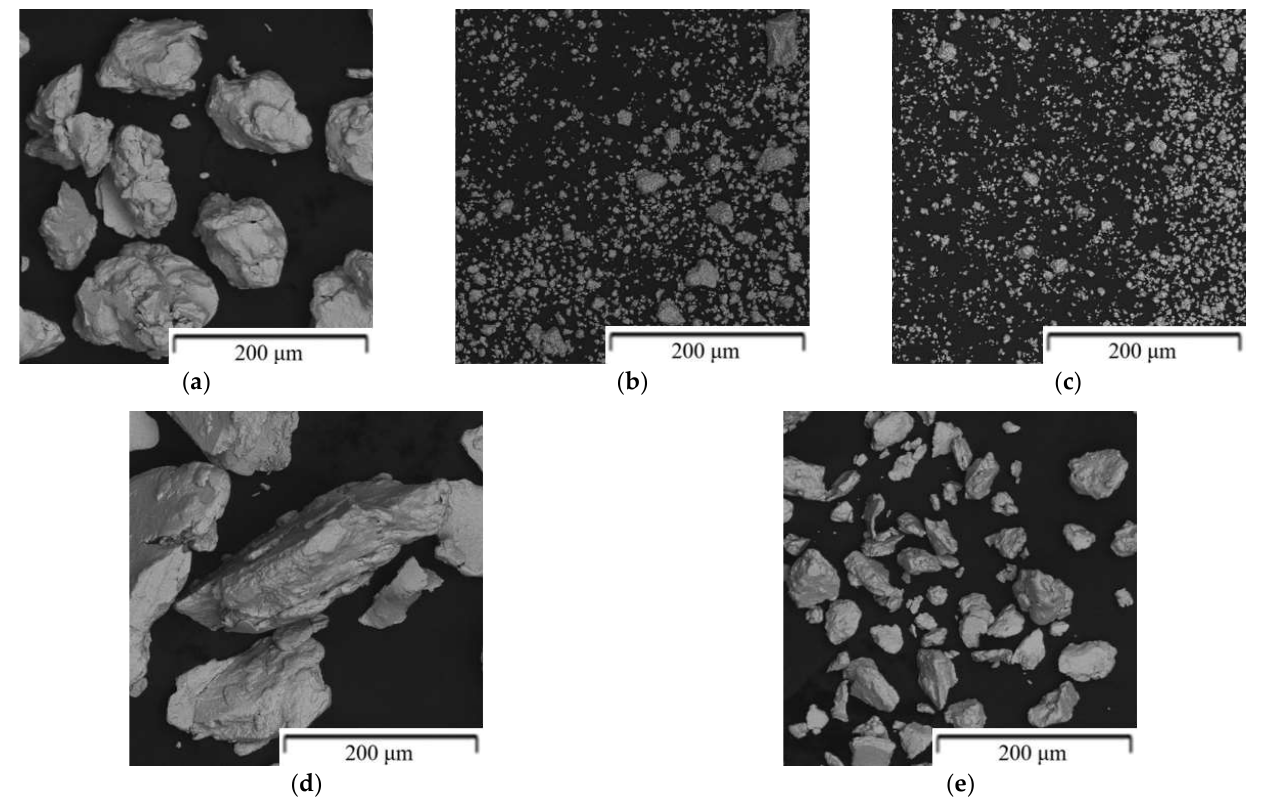
Figure 4. Shape and morphology of the powders prepared by mechanical alloying: ( a ) Zn-1Mg (1200